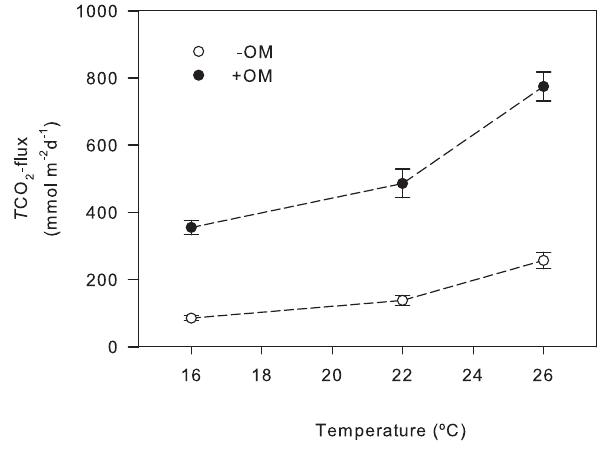
Figure 1. Mineralization rates, shown as flux rates of total CO 2 (mean ± SE, n = 6) versus temperature under nonorganically ( − OM) and organically polluted ( + OM) conditions modified from Sanz-Lázaro et al. (2011b). Lines are shown to visualize the trajec- tory but do not represent a